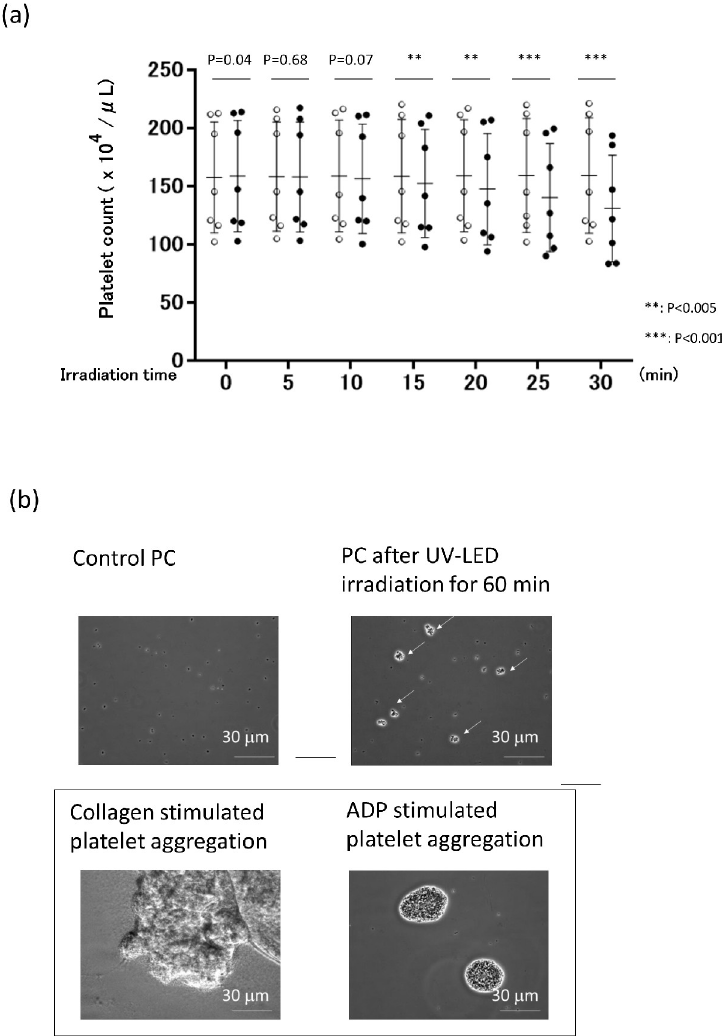
Fig 3. Effects of UV-LED irradiation on platelet counts and aggregation. (a) Seven independent experiments of control (non-irradiated) and UV-LED-irradiated samples are displayed as open and closed circles, respectively. Mean values ± SD are shown as one long and two short horizontal bars. Based on the mean absorbance of PC samples, irradiation times of 5, 10, 15, 20, 25, and 30 min correspond to fluence values of 4.6, 9.2, 13.9, 18.6, 23.5, and 28.5 mJ/ cm 2 , respectively. (b) After a 60-min irradiation, PCs were fixed with 1% paraformaldehyde (PFA). For preparation of agonist-induced aggregation, PCs were incubated with 10 μ g/mL collagen and 20 μ M ADP for 5 min and subsequently fixed with PFA (inset). A representative image from three independent experiments is shown. Arrowheads indicate UV-LED-induced